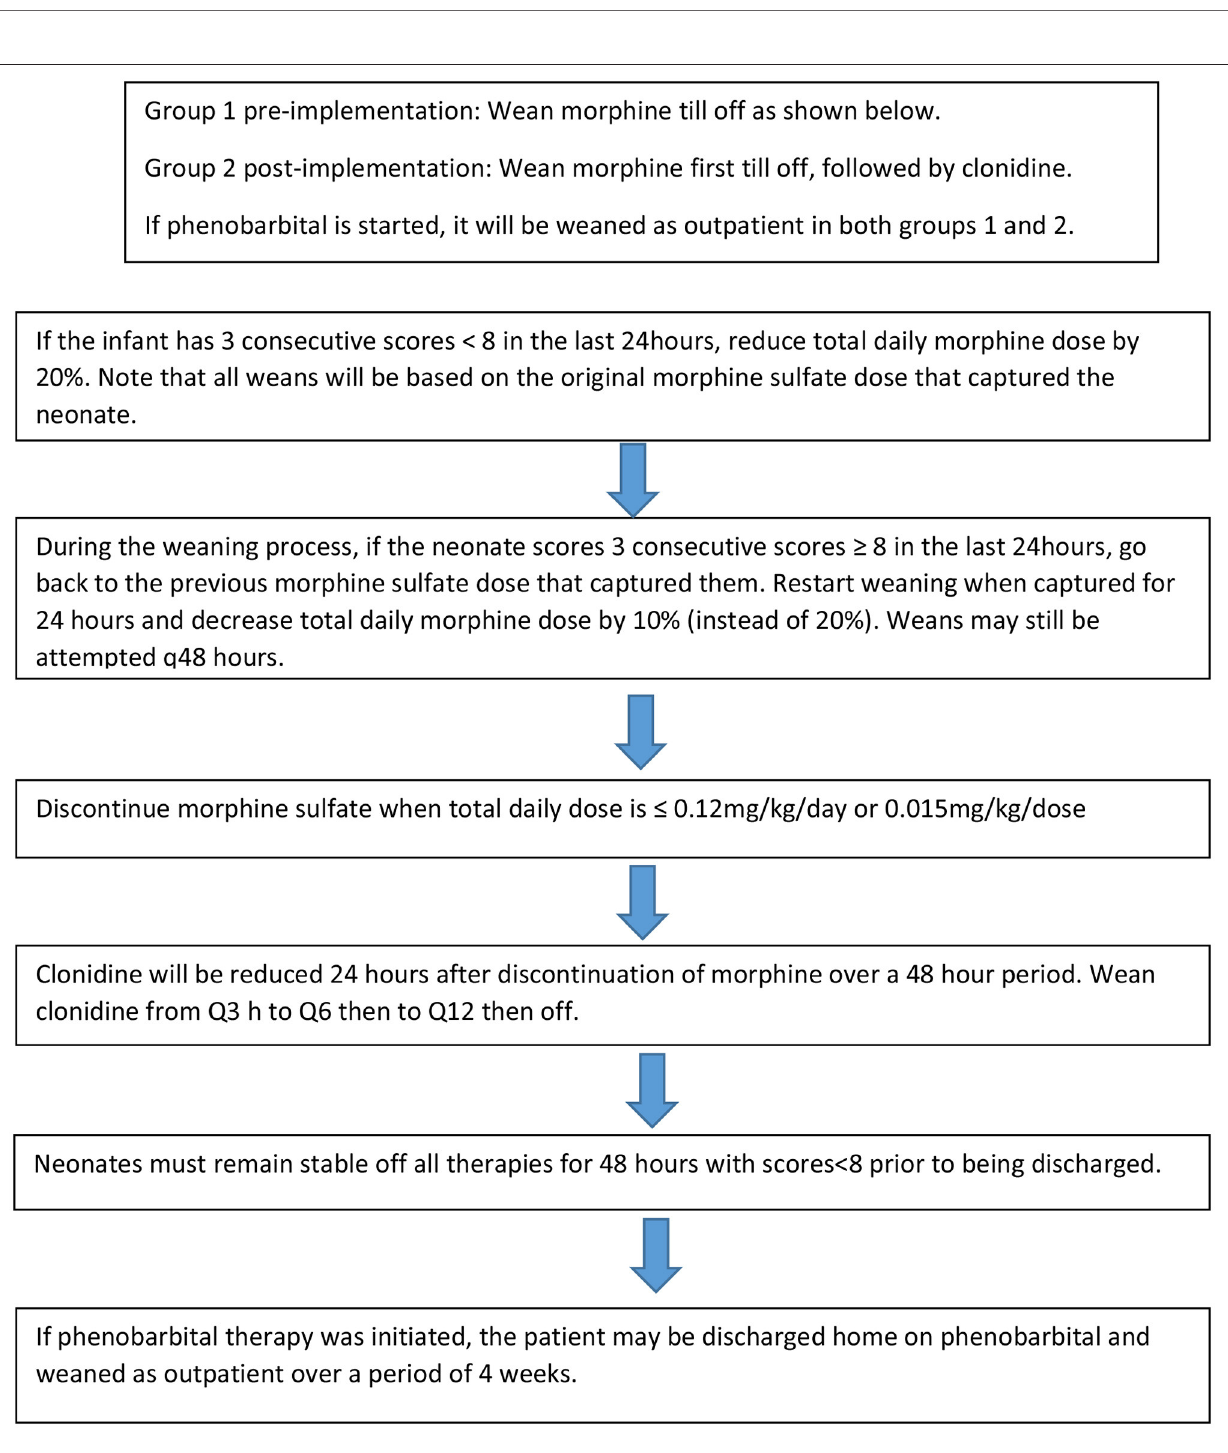
FIGURE 2 | Neonatal Abstinence Syndrome Treatment Algorithm Weaning